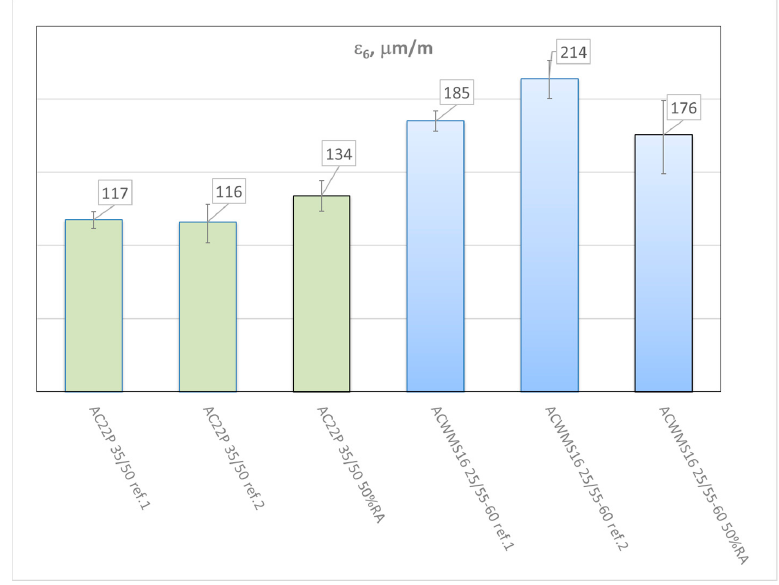
Figure 5. Comparison of the ε 6 parameter of the individual mixtures and the 95% confidence intervals.